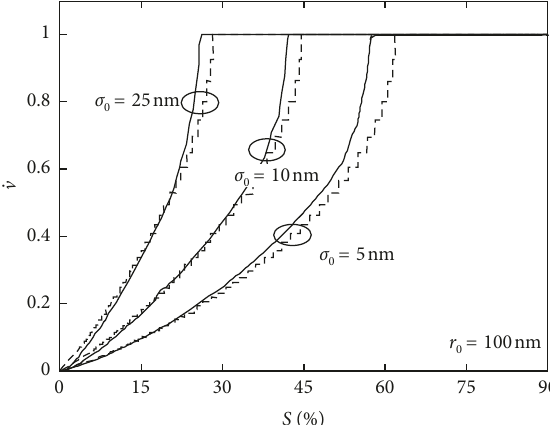
Figure 15: Simulation results using the continuous approach (solid lines) and discrete approach (dashed lines) for an infinite plate with a thickness of 200mm: normalized evaporation